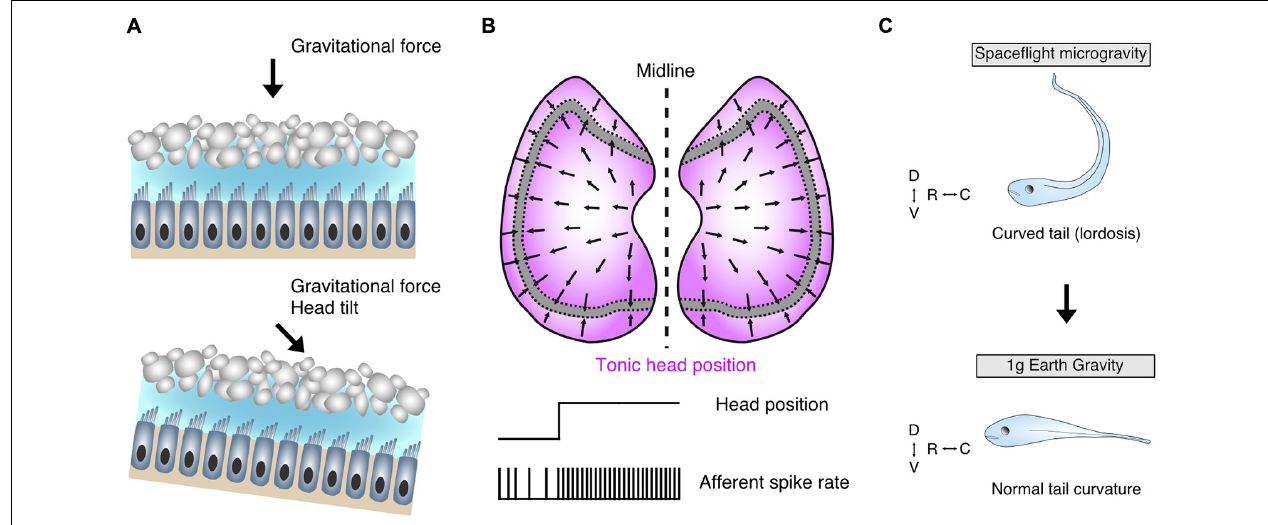
FIGURE 2 | Morpho-physiological features of the utricle and its contributions to body shape formation. (A) Schematic of utricular epithelia depicting hair cells with ciliary bundles embedded in a gelatinous matrix and its associated dorsally located otoconia; upright non-tilted head position establishes a perpendicular shearing force on overlaying otoconia (upper panel), whereas head-tilt (lower panel) shifts the directional vector of the shearing force and concomitantly alters the membrane potential and associated transmitter release of the hair cells. (B) Full spectrum of directional sensitivity domain vectors of hair cells in bilateral utricular sectors (upper); extrastriolar regions (magenta) flanking the striola are most sensitive to head tilt with corresponding tonic firing characteristics of innervating afferent fibers (lower). (C) Early loss of bilateral utricular input in Xenopus laevis by exposure to microgravity conditions contributes to a curved tail (lordosis) phenotype (upper), which abates upon return to earth’s gravitational space (lower) confirming the influence of bilateral utricular input on body shape formation. D, dorsal; V, ventral; R, rostral; C, caudal. Schematic in C based on data from Horn